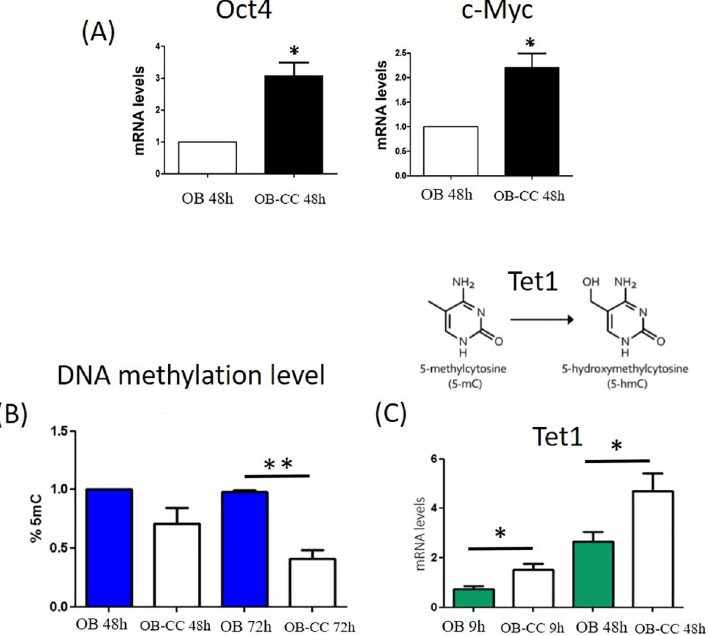
Fig 4. Cell transdifferentiation is associated with a gene-reprogramming event and global epigenetic remodelling. (A) OCT4 (octamer-binding transcription factor 4) and c-MYC (oncogene myc) mRNA expression levels in OB and OB-CC after 48 h of coculture. mRNA expression levels were normalized to OB expression against the signal from two housekeeping genes, peptidylprolyl isomerase A (PPIA) and tyrosine 3-monooxygenase/tryptophan 5-monooxygenase activation protein (YWHAZ). Graphs are representative of 4 independent experiments (donors A, C, D, G) performed in duplicate. Error bars show the standard deviation. � P � 0.05, cocultured osteoblasts (OB-CC) compared to osteoblasts grown alone (OB). (B) Percentage of 5-methylcytosine in DNA from OB and OB-CC after 48 and 72 h of coculture. Graphs are representative of 5 independent experiments. Error bars show the standard deviation. No significant changes were observed after 48 hours of coculture, but 72 hours of coculture induced significant hypomethylation. �� P � 0.01. (C) TET1 (ten-eleven translocation methylcytosine deoxygenase 1) mRNA expression levels in OB and OB-CC cells after 9 and 48 h of coculture. mRNA expression levels were normalized to OB expression against the signal from two housekeeping genes for peptidylprolyl isomerase A (PPIA) and tyrosine 3-monooxygenase/ tryptophan 5-monooxygenase activation protein (YWHAZ). Graphs are representative of 4 independent experiments performed in duplicate. Error bars show the standard deviation. � P � 0.05, cocultured osteoblasts (OB-CC) compared to osteoblasts grown alone